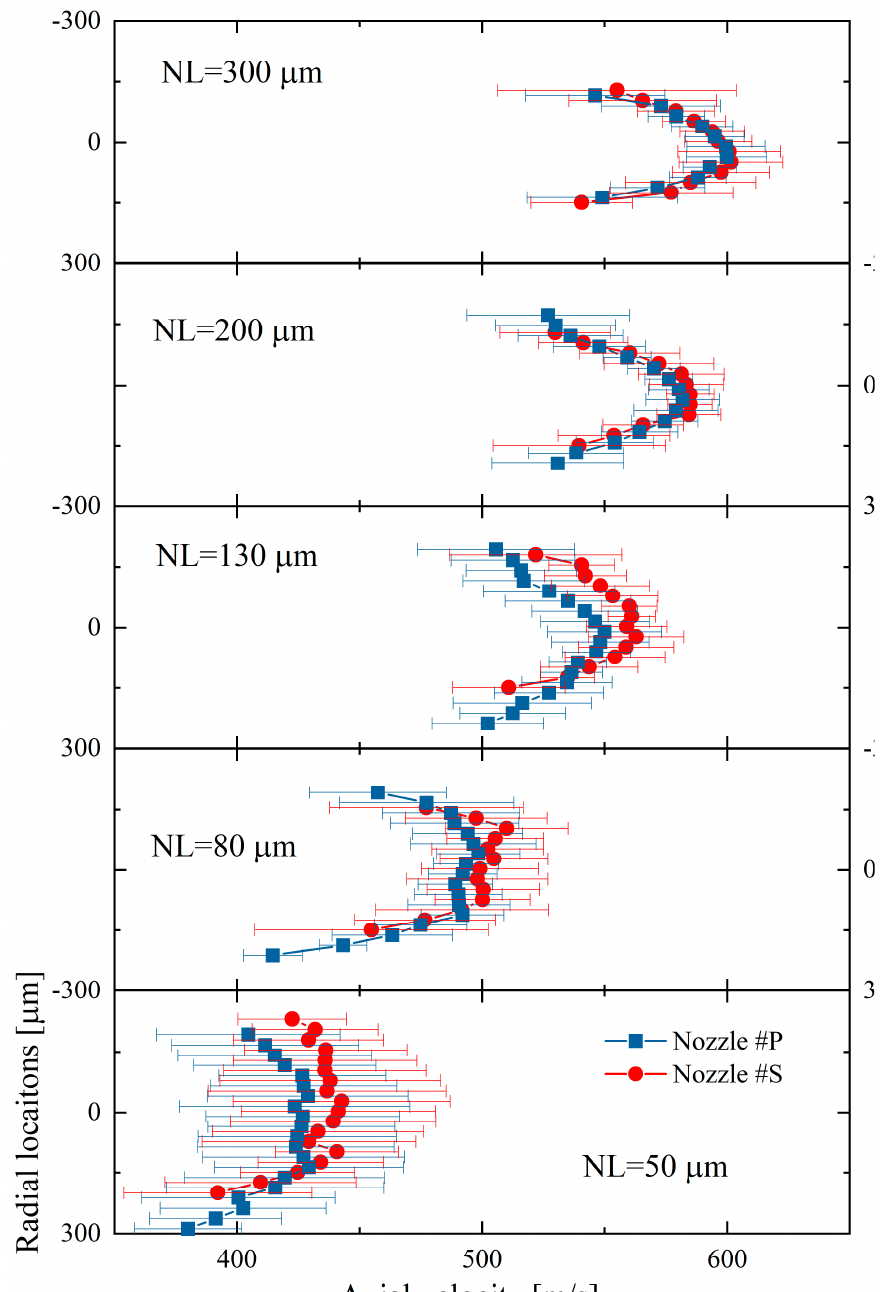
Figure 8. Nozzle − exit spray velocity distributions at different needle lifts.